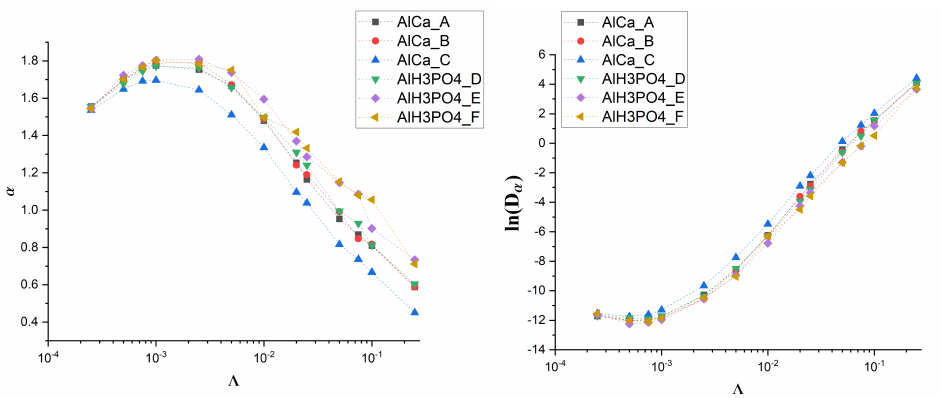
Figure 6. Dependence of α ( left ) and ln D α ( right ) on drift for various